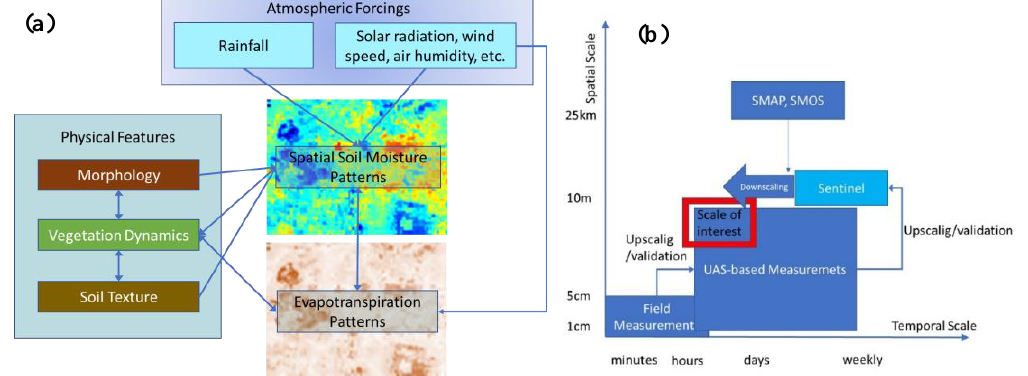
Figure 2. ( a ) Physical features influencing the spatial dynamic of soil moisture; ( b ) Identification of the temporal and spatial scales of different monitoring techniques.